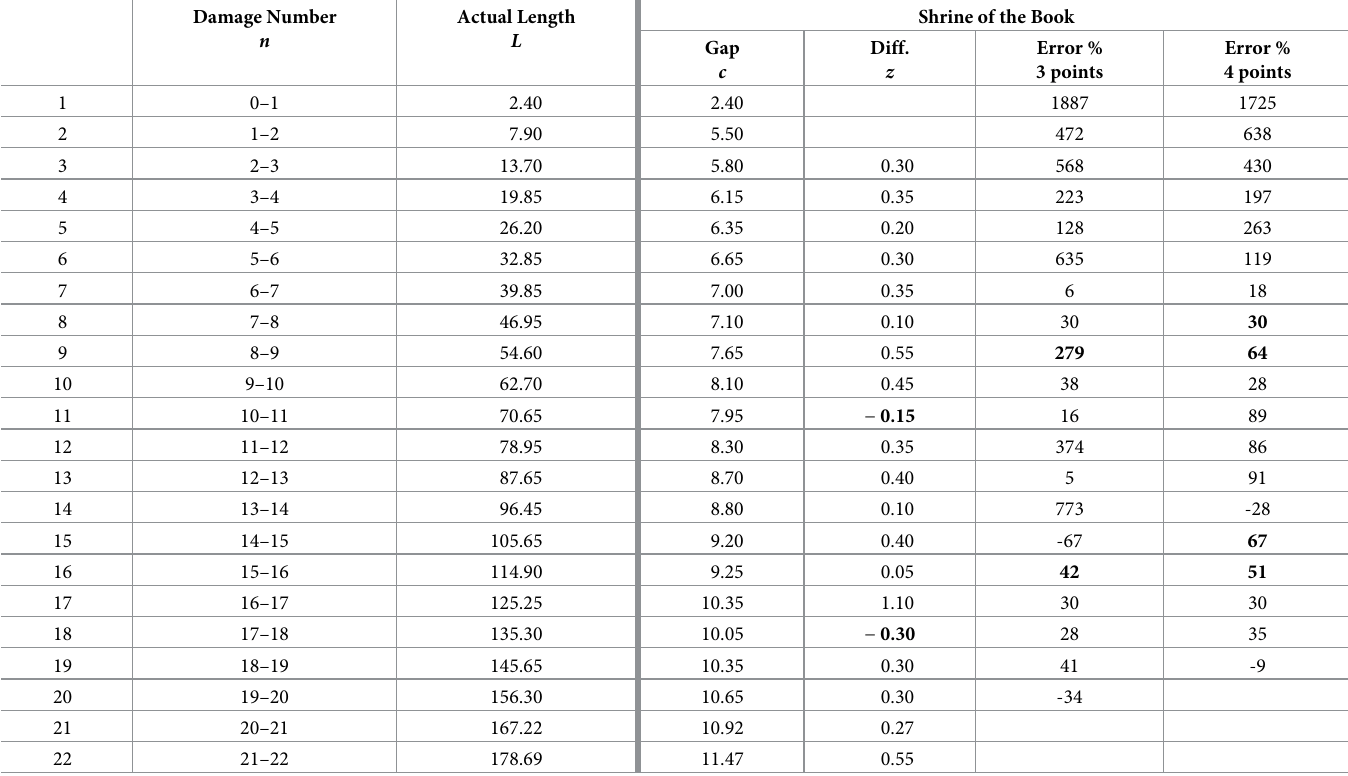
Table 6. Community Rule ,